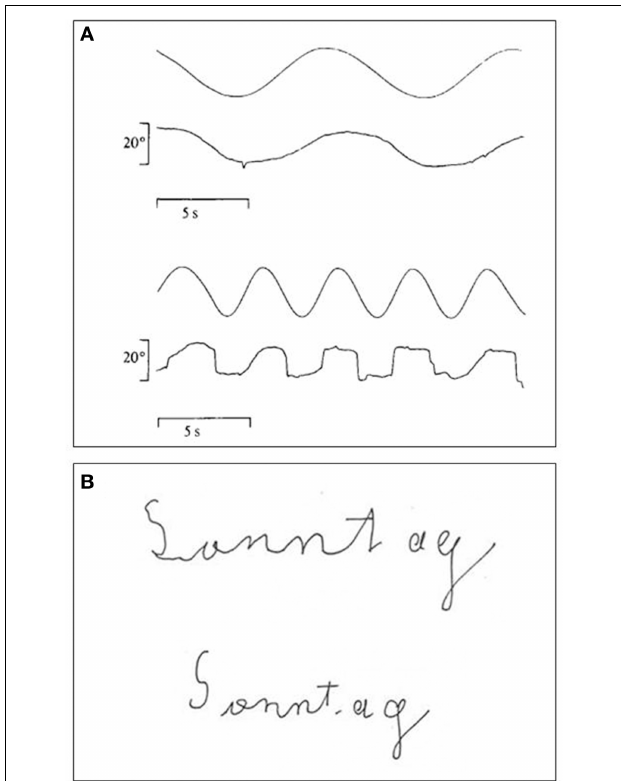
FIGURE 6 | (A) Recordings of LM’s smooth pursuit eye movements to a target moving either at 4 ◦ /s (upper trace) or at 8 ◦ /s (lower trace). Note deterioration of smooth pursuit at the higher velocity (modified after Zihl et al., 1983; ©Oxford University Press with permission). (B) Handwriting with eyes open (upper writing) and eyes closed (lower writing). Time taken for writing was 4s with eyes closed and 26s with eyes open (modified after Heywood and Zihl, 1999, ©Psychology Press with permission). Note better writing with eyes